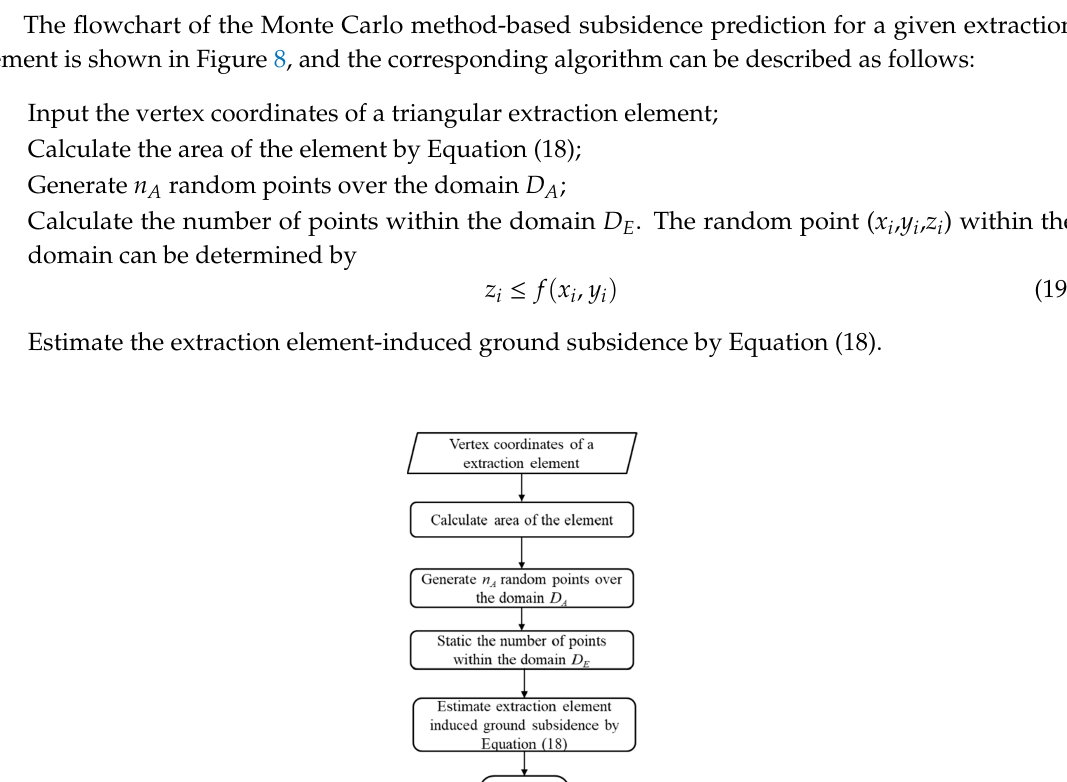
Figure 7. The idea of the integral I E estimation model based on the Monte Carlo method.